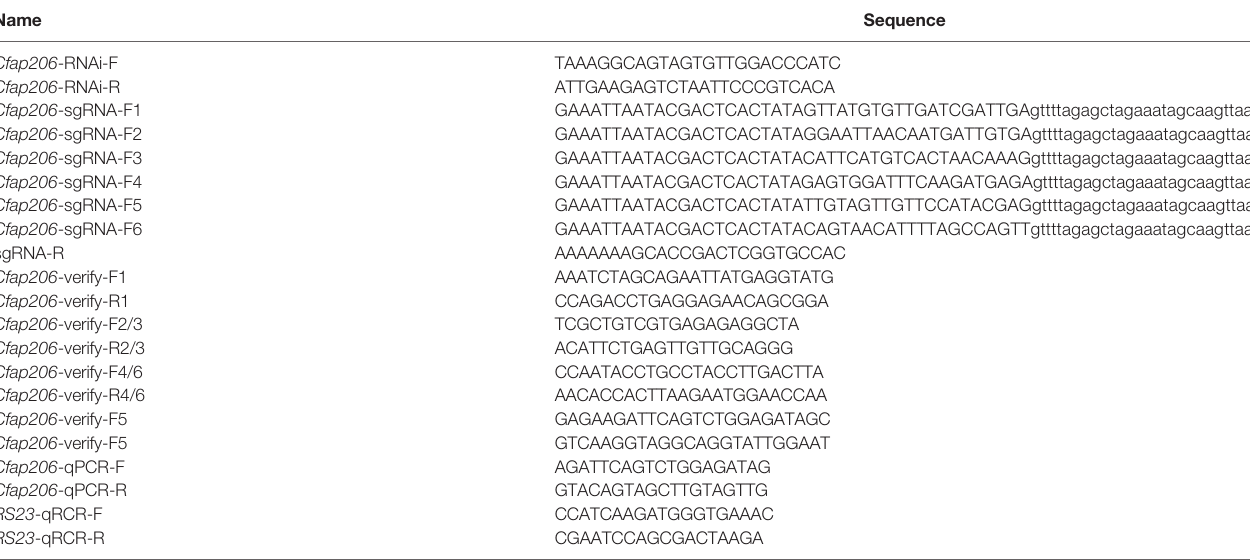
TABLE 2 | Primers used for RNAi, qPCR, sgRNA synthesis, and PCR